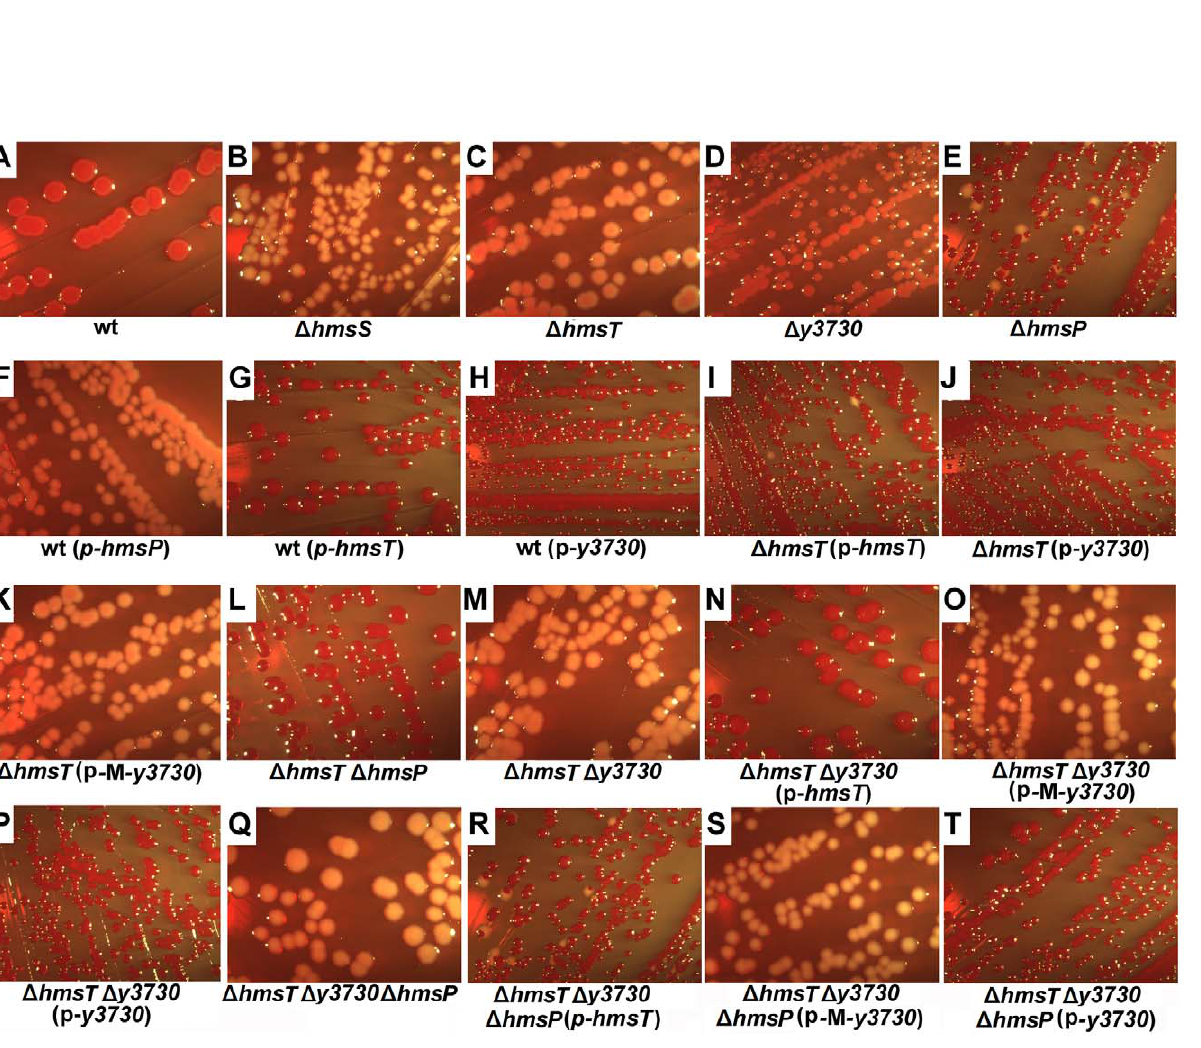
Y.pstb b Comparison with Y.pstb homologue